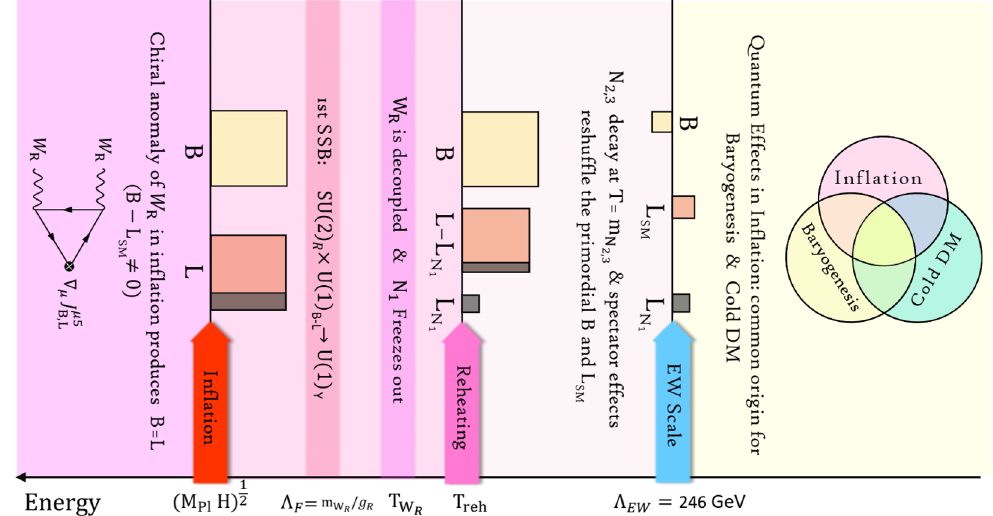
Figure 2 . Summary of the mechanism: illustration shows the evolution of baryons B (yellow box), SM leptons L